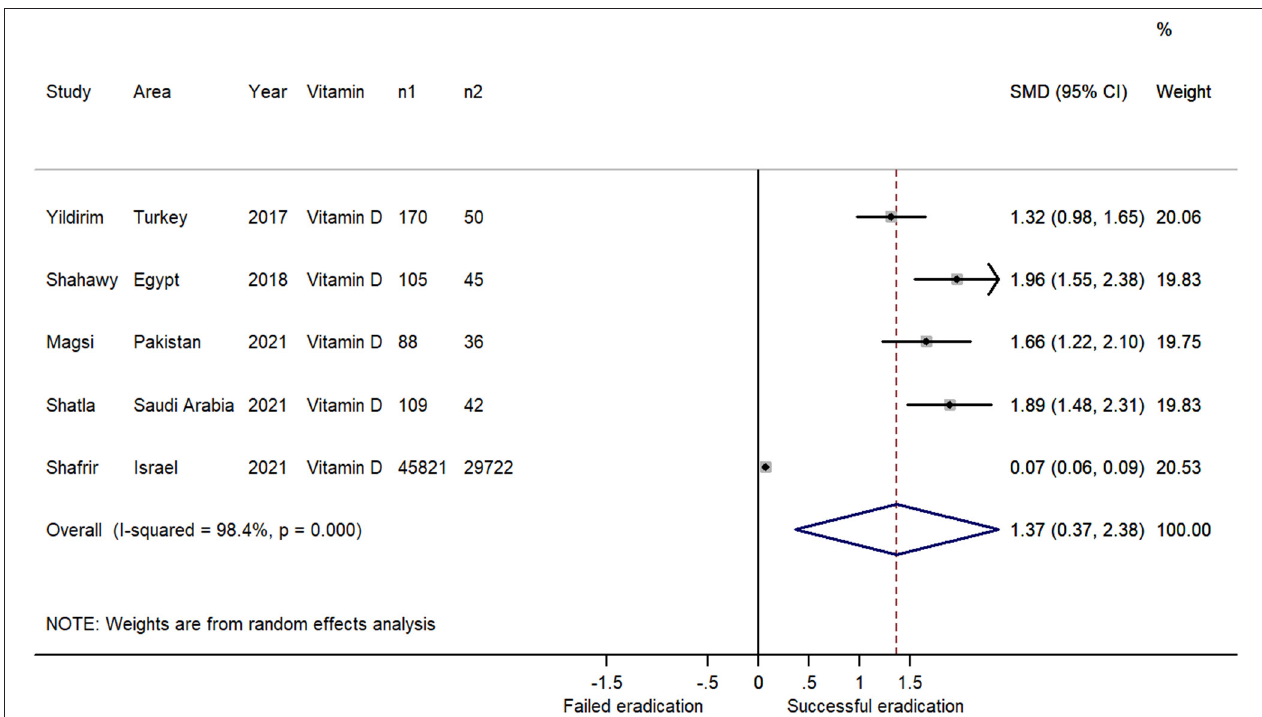
FIGURE 4 | Forest plot of the meta-analysis on the comparison of serum vitamin levels between H. pylori successful and failed eradication patients (n1: number of successful eradication patients; n2: number of failed eradication patients); The patients with successful H. pylori eradication had higher serum vitamin D levels than